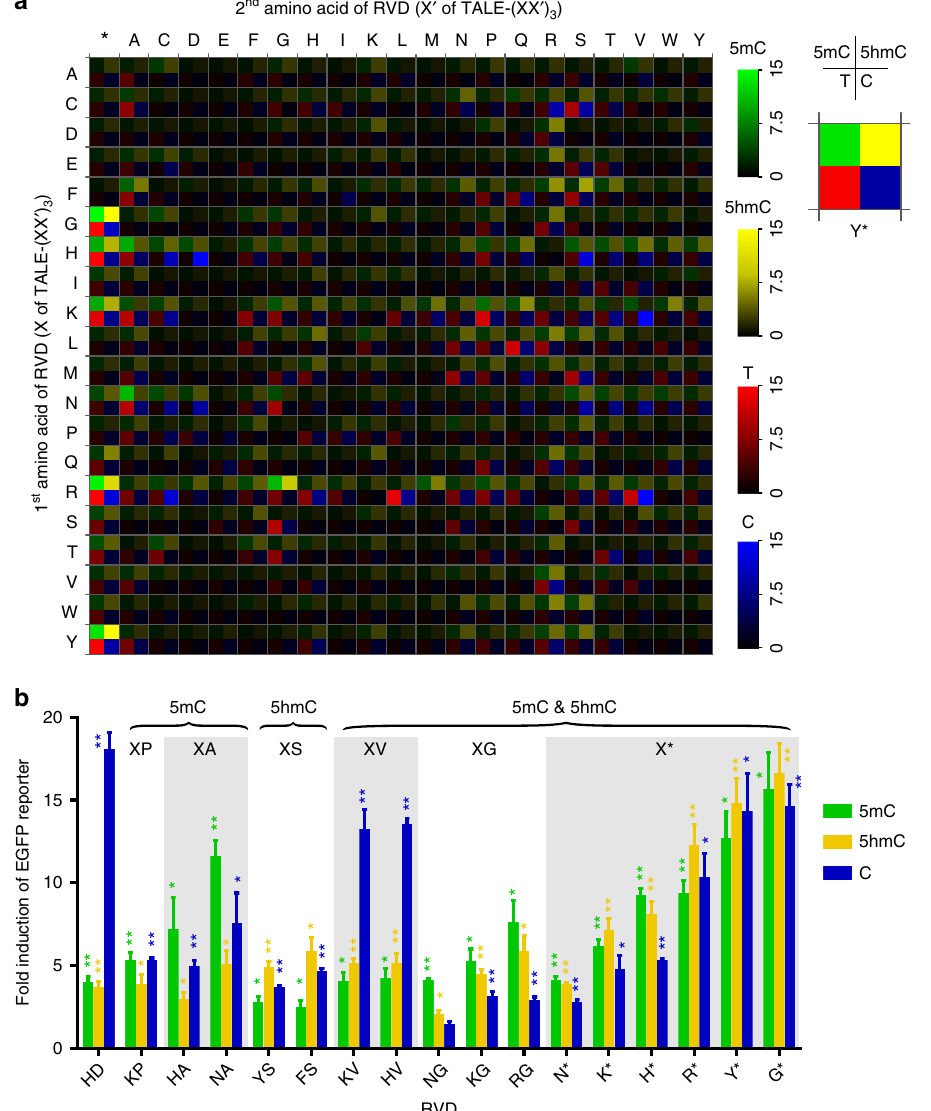
Fig. 2 Complete assessment of the ef fi ciencies and speci fi cities of TALE RVDs towards 5mC and 5hmC. a A heat map summarizing the screening data of 5mC and 5hmC. For easy comparison, the results for unmodi fi ed C and T reporters are also shown. EGFP activities from different reporters are coded using different colors representing the reporter identities (5mC, green ; 5hmC, yellow ; T, red ; C, blue ), and the brightness of the colors indicates the fold induction of reporters by TALE-(XX ′ ) 3 normalized to the basal levels. The single-letter abbreviations for the amino acids are used. The upper right side legend shows the speci fi c heat map of Y*. Starting from the top left , the DNA reporter is 5mC, 5hmC, T and C, respectively. b Modi fi ed cytosine preference of RVDs. RVDs are clustered according to base preference and are categorized by the 13 th residue in each cluster. The data are means + s.d., n = 3; * P < 0.05, and ** P < 0.005 two-tailed unpaired Student ’ s t